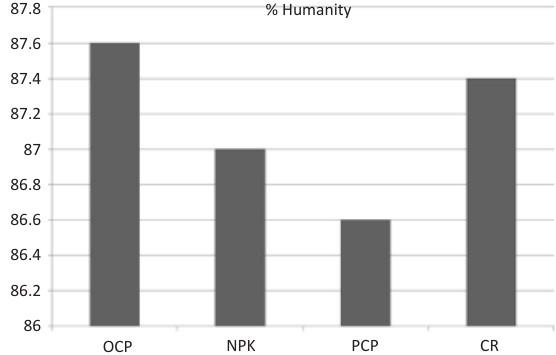
Figure 4. Abundance of amphibians across three different coffee plantation regimes and control